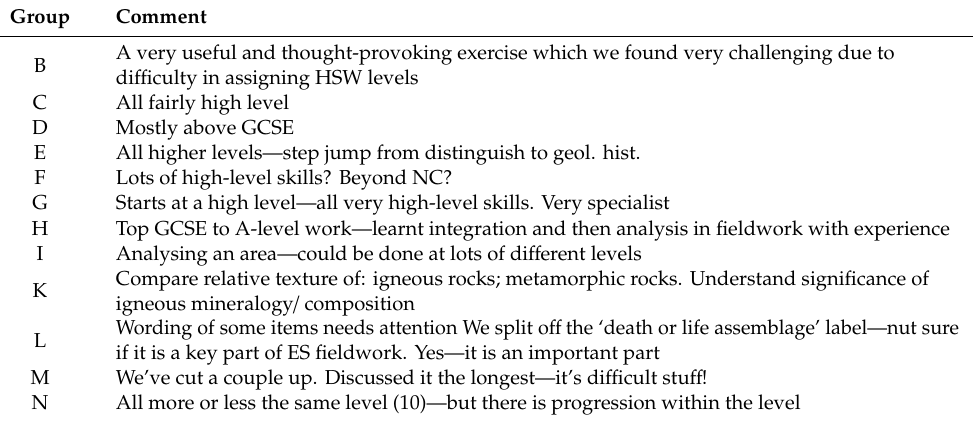
Table A8. Collect and use geological information e ff